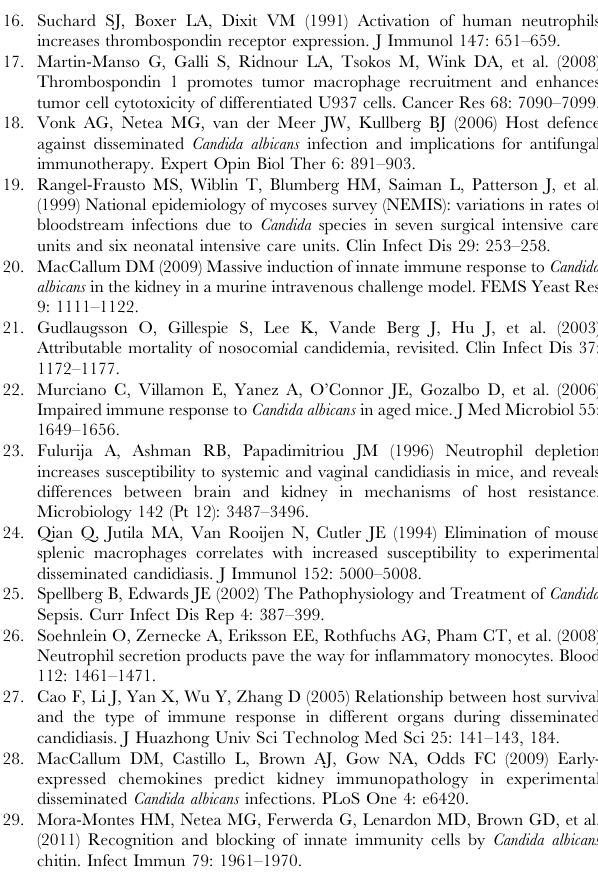
Figure S5 TSP1 may regulate phagocytosis via extracel- lular release of O 2 2 . A). Structural model of TSP1 and trimeric recombinant NH 2 -terminal, NoC1 ( top ). Bottom , 1 6 10 5 IFN- c - differentiated U937 cells/condition were incubated with fluores- cein-labeled E. coli in the absence or the presence of soluble TSP1 (5, 10 and 20 m g/ml) or recombinant NoC1 (5 m g/ml) for 2 h. The fluorescence was measured in a fluorometer (GENios Plus Tecan). The results (mean 6 SD) are presented as RFU and are representative of two independent experiments. (B) 1 6 10 5 IFN- c - differentiated U937 cells/condition were incubated with fluores- cein-labeled E. coli in the absence or the presence of 1/100, 1/10 xanthine oxidase (XO) (0.02 U/ m l) (Stratagene) for 2 h. The fluorescence was measured in a fluorometer (GENios Plus Tecan). Representative experiment (mean 6 SD) presented as RFU. Figure S6 Renal KC, MIP-2 and DCIP-1 mRNA levels in wt and tsp1 2 / 2 C57BL/6 mice. Real-time quantitative